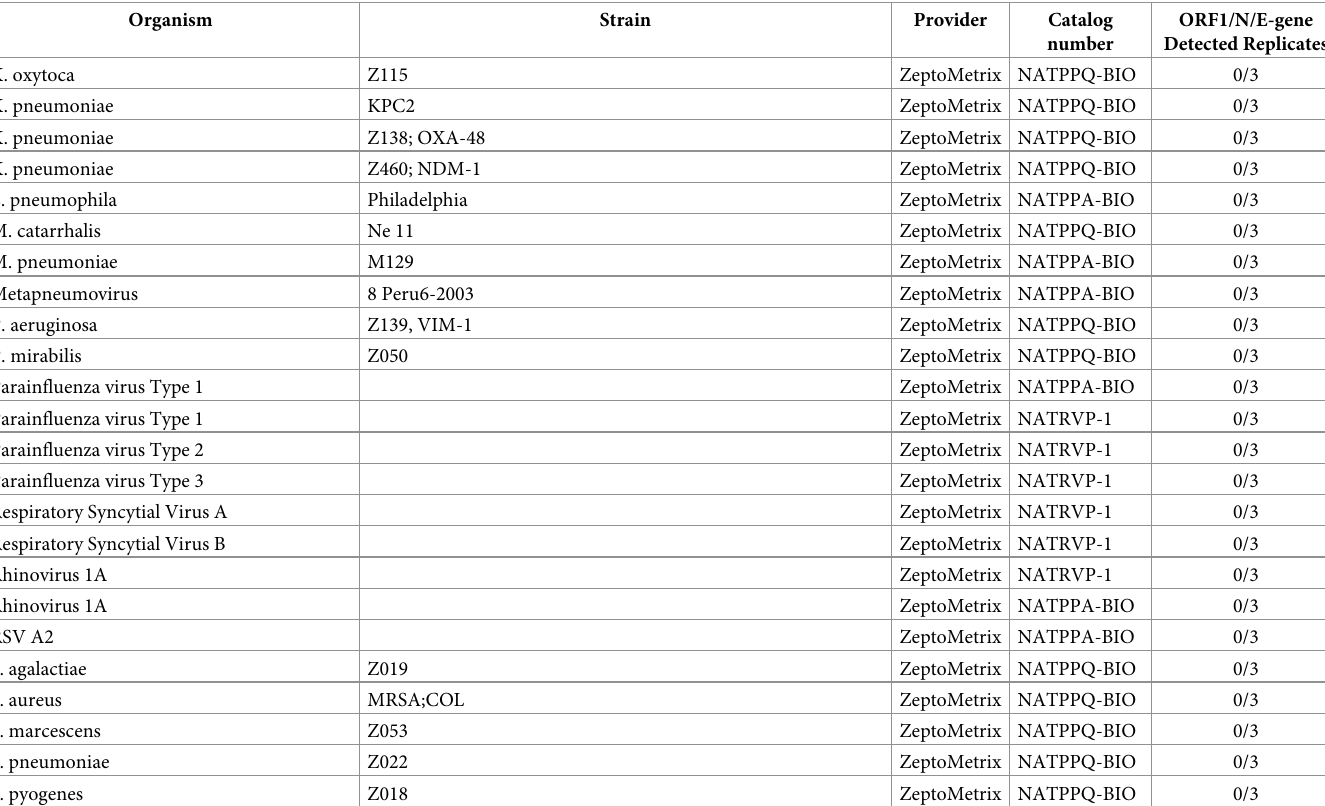
consistency and reproducibility. The LoD determination of the Prime CovidDetect ™ Rapid Detection kit was 80 copies/ μ L, Table 6. The amplification plots of the 24 replicate wells for SARS-CoV-2 are shown in Fig 1; specifically, Orf1, E1, N2 genes (Fig 1A), and the 18S RNA control gene (Fig 1B). The positive control (Fig 1C and 1D) was SARS-CoV-2 (heat-inacti- vated and spiked as previously described) at the dilution at 10,000 copies/ μ L (six replicates) and the No Template Control (Fig 1E and 1F) was Nuclease-Free water (6 replicates).